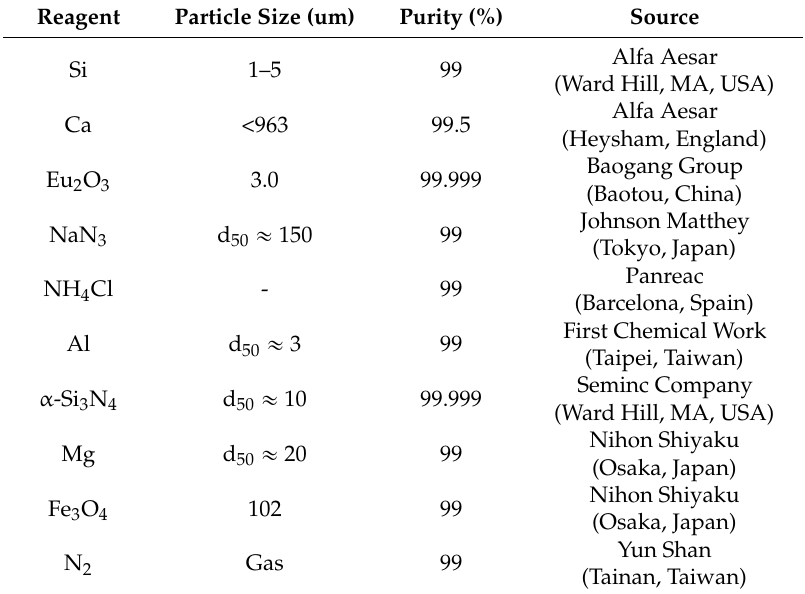
Table 3. Characteristics of the Reagents Used in this